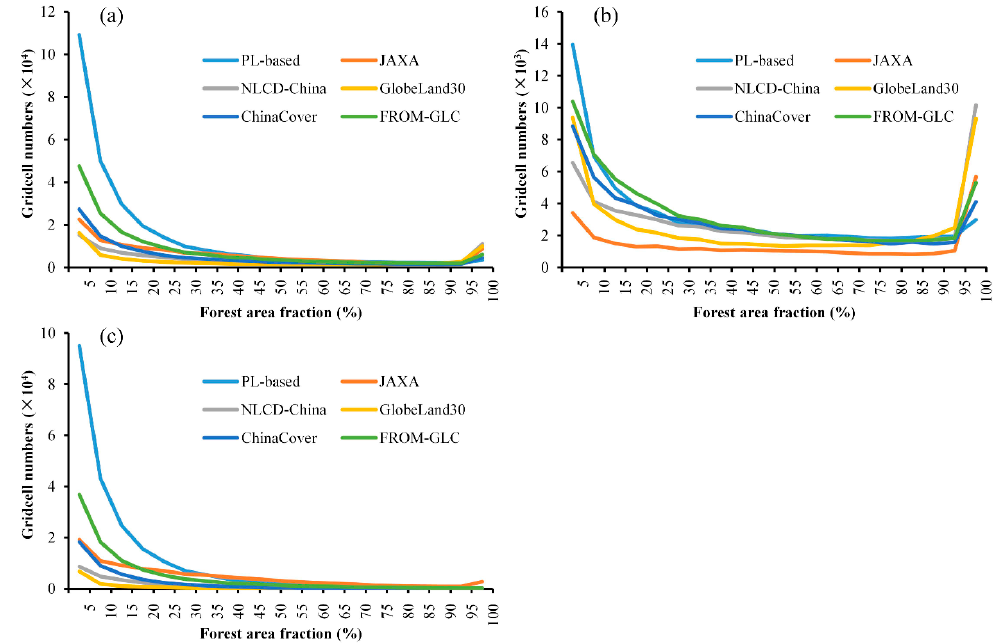
Figure 11. The distribution of different intensity of forest fraction gridcells at 900-m resolution in the; ( a ) North China Plain (NCP); ( b ) mountain region; and ( c ) plain region according to the six different forest maps.